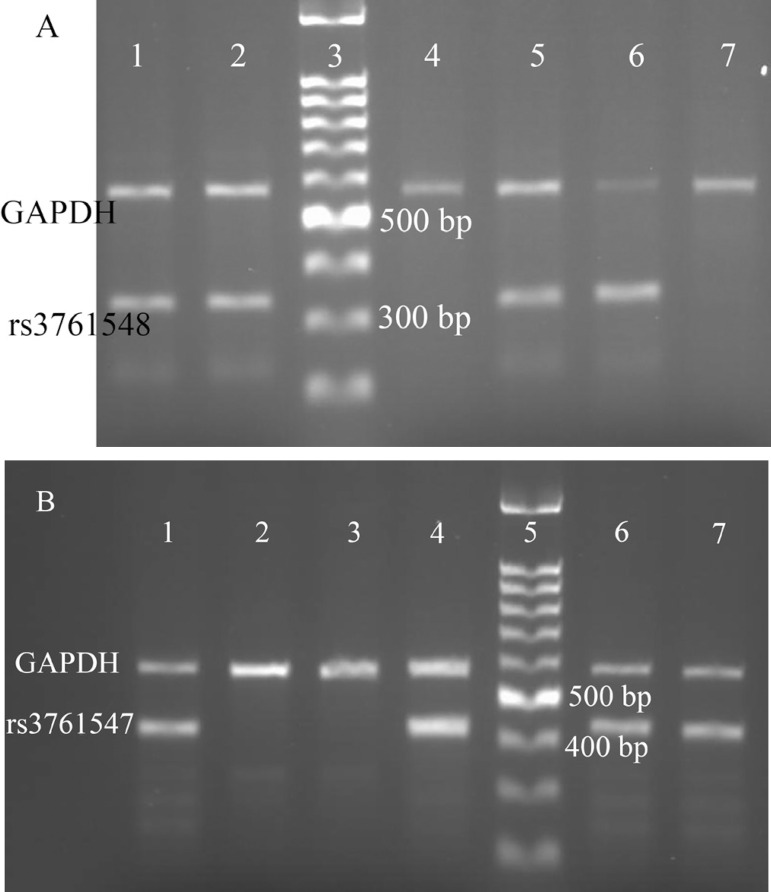
Gel electrophoreses of the polymerase chain reaction products for analysis of FoxP3 polymorphisms. Glyceraldehyde 3-phosphate dehydrogenase (GAPDH) was used as internal positive control. A) FoxP3 rs3761548 polymorphisms; lane 1,2: AC heterozygote; lane 3: 100 bp molecular weight marker; lane 4,5: AA homozygote; lane 6,7: CC homozygote. B) FoxP3 rs3761547 polymorphisms; lane 1,2: TT: homozygote; lane 3,4: CC homozygote; lane 5: 100 bp molecular weight marker, lane 6,7: CT: heterozygote.